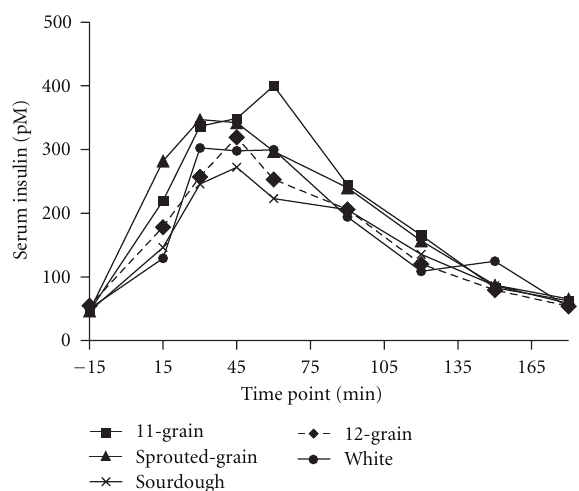
Figure 2: Fasting and postprandial insulin response to the ingestion of 50 g available carbohydrate of the test breads. Data are means. Standard errors are not included for clarity, n = 12. Test bread was ingested after collection of fasting blood sample at time point − 15 min. Significant overall treatment e ff ects were identified (11- grain bread was greater than sourdough ( P < 0 . 005) and white ( P < 0 . 03)